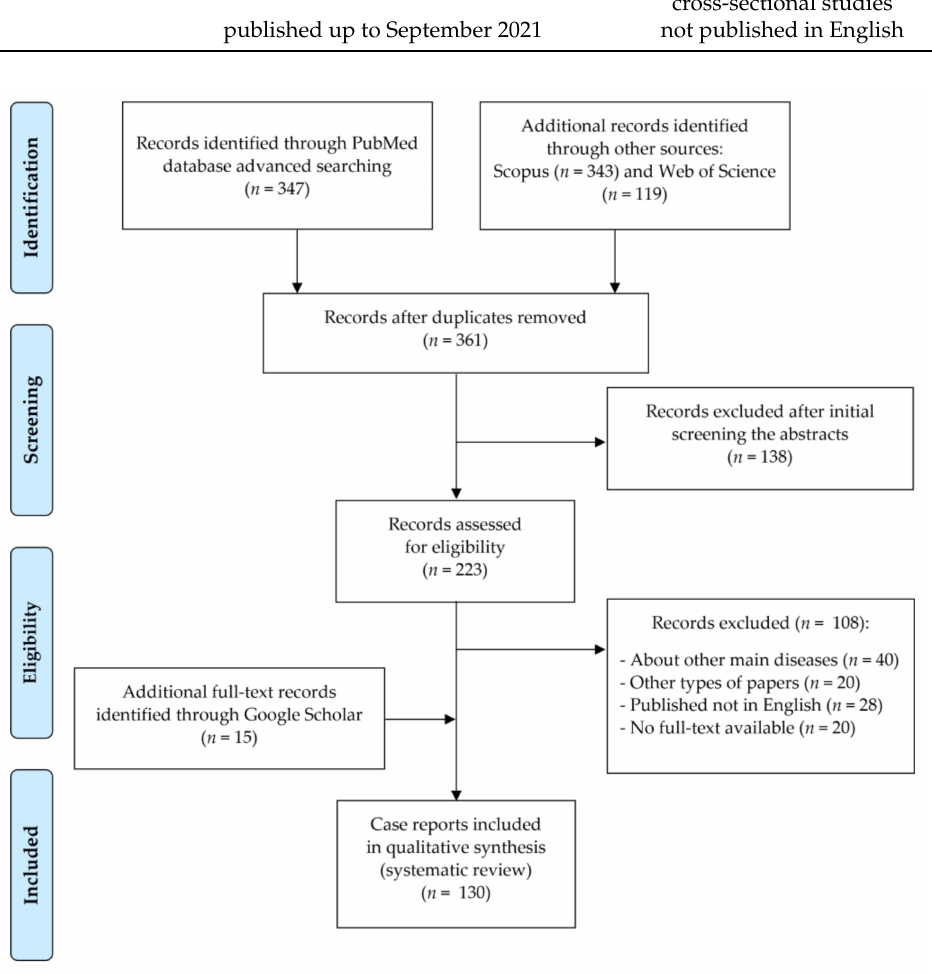
Figure 2. PRISMA flow diagram presenting the detailed search